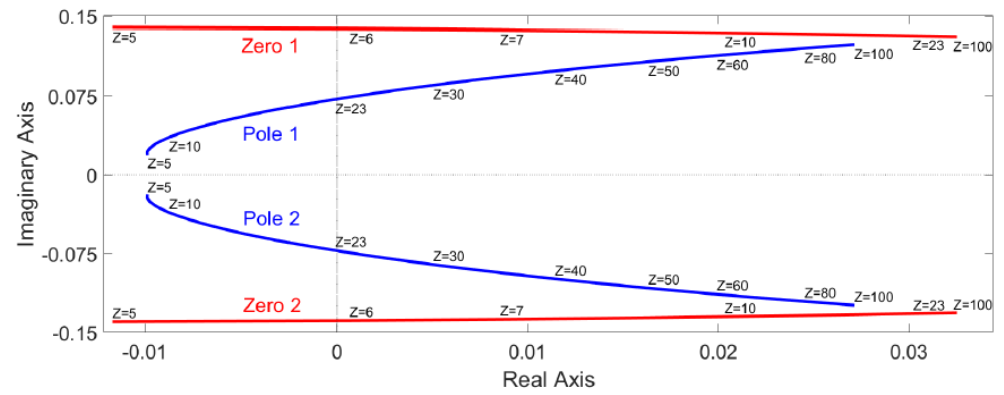
Figure 5. The pole-zero map of z to P t ’s transfer function with linearizations from 5 to 100% valve openings. The model consists of 4 poles and 3 zeros. It is clear that two dominated conjugated poles (blue) approach the two Right Half-Plane (RHP) zeros (red) at high valve openings. The last 2 poles and zero are located far out on Left Half-Plane (LHP) real axis (not plotted) and are thus insignificant to the system performance.